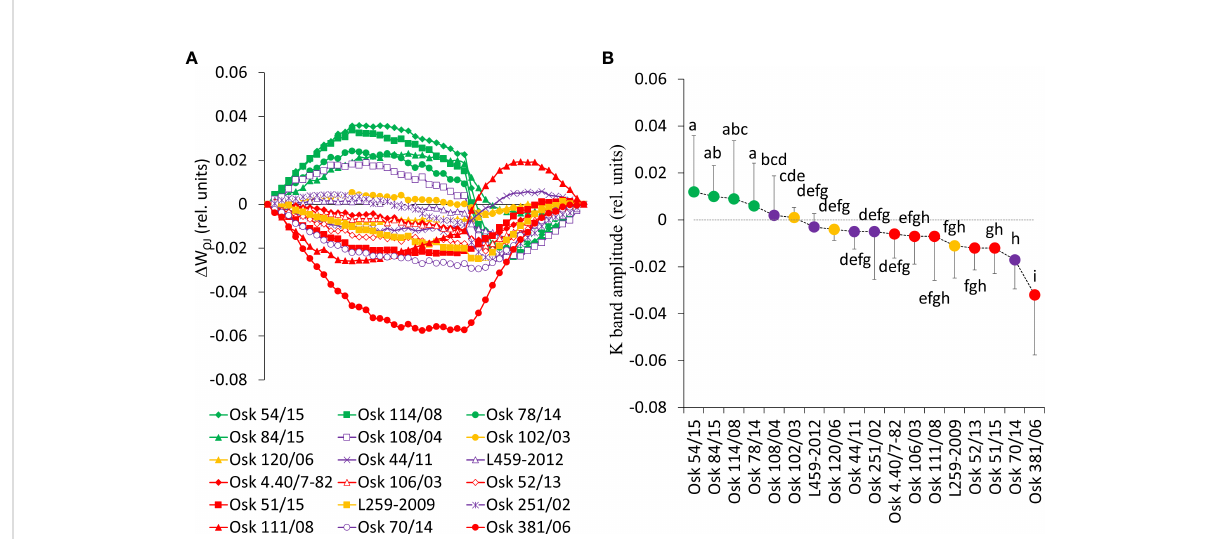
FIGURE 6 (A) Differential curves of relative variable fl uorescence O-J normalized induction curves for eighteen wheat genotypes as W OJ = (F t -F o )/(F J -F o ), each line averages 20 measurements. For the analysis of different kinetics and to reveal the band (K-band) that is typically hidden between steps O and J, the divergences between the relative variable fl uorescence curves of the stress treatment (PEG induced water de fi cit, Y = -0.33 MPa) and control ( fi eld conditions, water potential Y = -0.03 MPa) were calculated as D W OJ = W Treatment – W Control . (B) Mean values of K-band divergences (dispersion refers to maximal values or amplitudes) and statistical differences among genotypes (one-way ANOVA F 17,810 = 37.3, p< 0.001, values followed by a common letter are not signi fi cantly different by the Tukey HSD-test at the 5% level of signi fi cance).